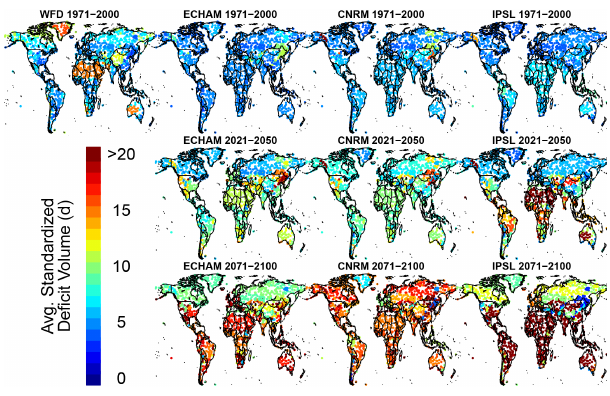
Figure 5. Spatial distribution of average standardized deficit vol- ume for different time periods, obtained from simulations of the conceptual hydrological model, using meteorological forcing by the WATCH Forcing Data (WFD) and three GCMs: ECHAM, CNRM and